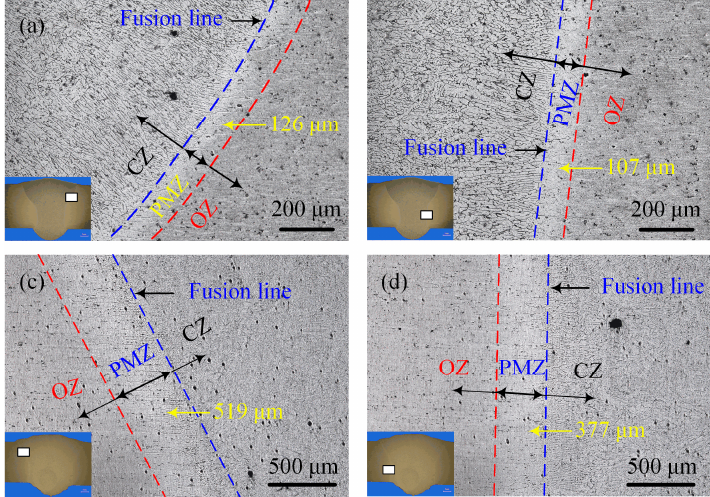
Figure 7. Microstructure near the fusion line. ( a ) arc zone of laser-CMT hybrid welded joint; ( b ) laser zone of laser-CMT hybrid welded joint; ( c ) arc zone of plasma-CMT hybrid welded joint; ( d ) plasma zone of plasma-CMT hybrid welded joint.